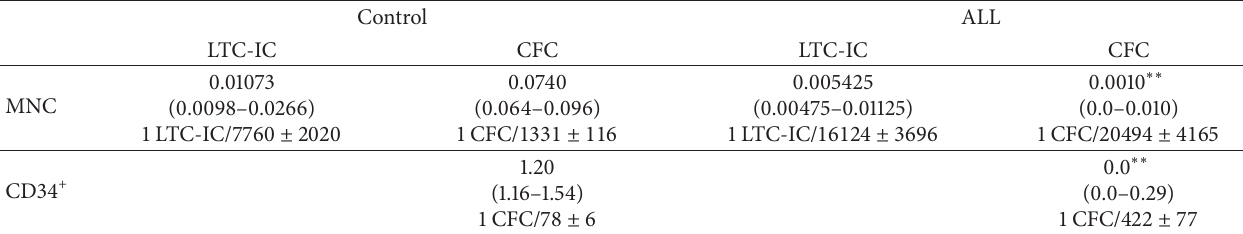
Table 1: Reduced stem and progenitor cell content in ALL bone